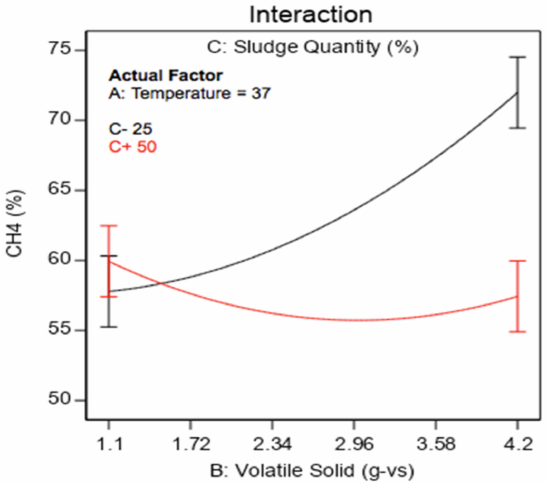
Figure 13. Interaction plot illustrates the effect of interaction between volatile solid and sludge quantity on CH 4